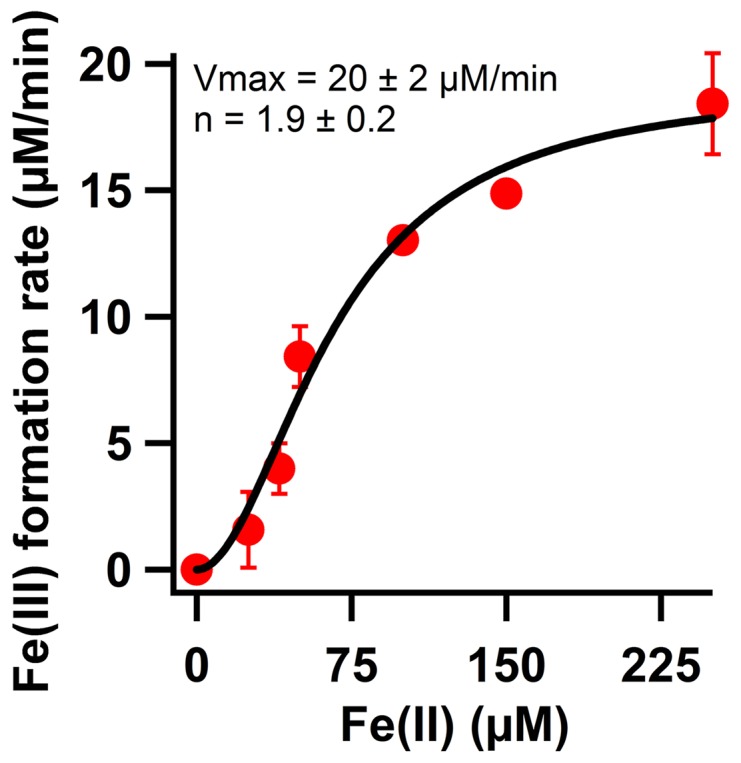
Effect of concentration of Fe(II) on non-enzymatic oxidation of Fe(II) and incorporation of the Fe(III) product into transferrin.Progress curves were recorded at 460 nm for formation of diferric-transferrin and the initial rates were plotted versus concentration of Fe(II). The error bars represent standard deviation of three independent measurements. Concentration of apo-transferrin was 100 µM. Buffer was 100 mM Hepes, 100 mM NaCl, pH 7.2. Measurements were performed at 37°C.